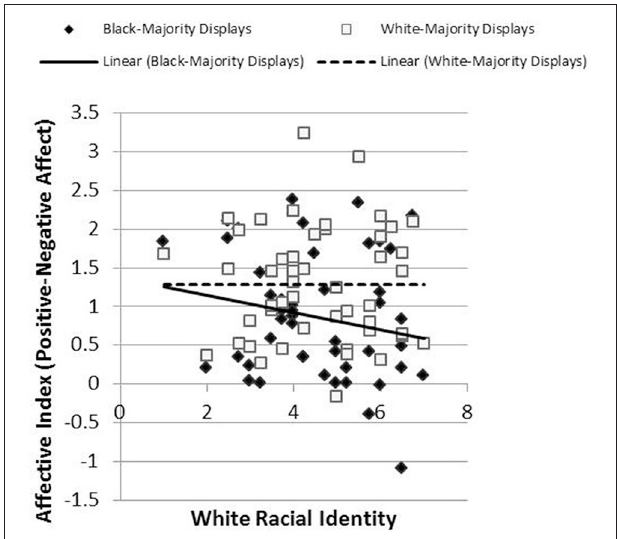
FIGURE 5 | Relationship between racial identity and affective responses to Black-Majority and White-Majority Black History displays, Study